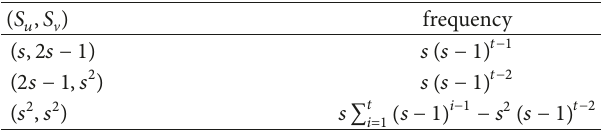
Table 4: Edge partition of 𝐶 𝑠,𝑡 based on degree sum of end vertices of each